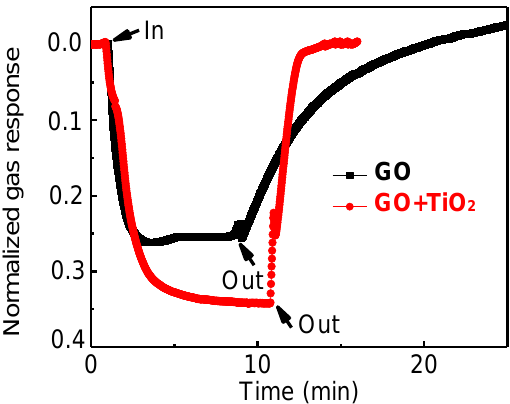
Figure 5. Comparative gas-sensing results of pure GO and GO/TiO 2 composite toward 100 ppm ammonia gas bubbling at room temperature (25 °C).